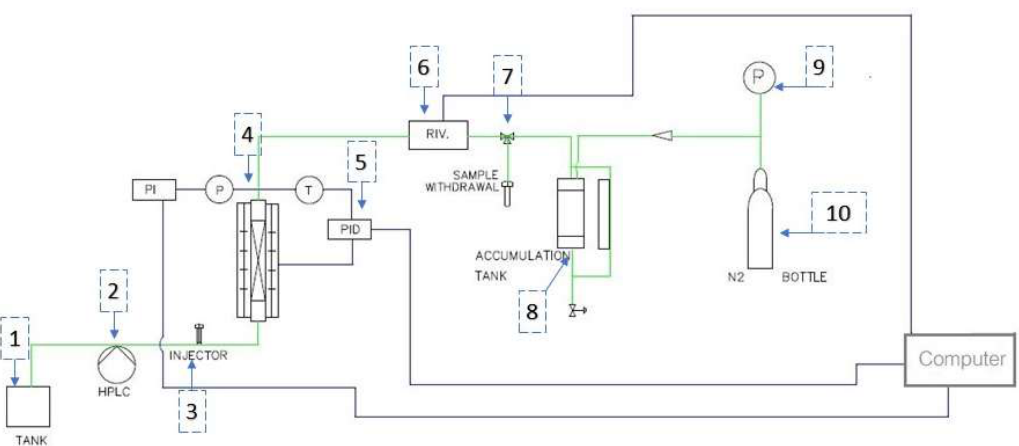
Figure 1. Chromatographic reactor setup scheme. (1) Tank; (2) HPLC pump; (3) injector; (4) chromatographic reactor; (5) PID; (6) online detector; (7) sample withdrawal valve; (8) accumulation tank; (9) reductor; (10) N 2 bottle.